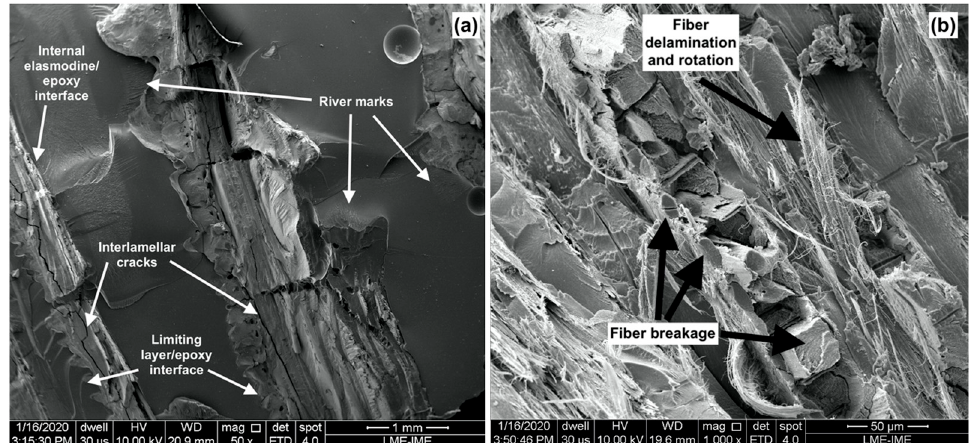
Figure 8. SEM image of the fracture surface of the composite with 20 vol% of arapaima scales after the Izod test with magni fi cations of: 50× ( a ) and 1000× ( b ).